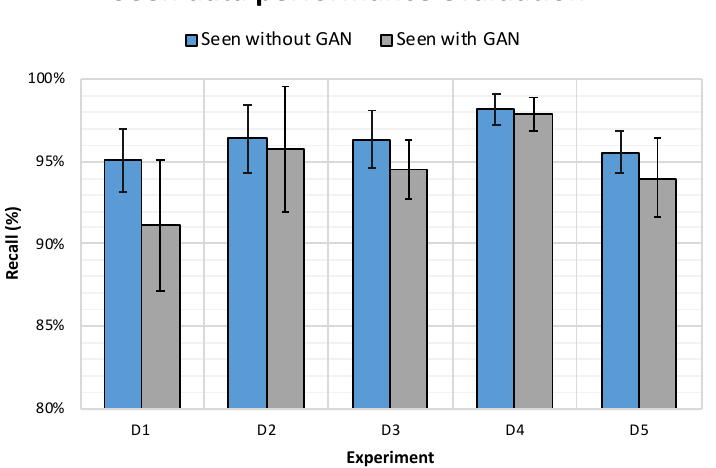
Figure 10. The performance of the average CNN models trained on R4 Vs. RG drone dataset and tested on seen drones of in terms of recall